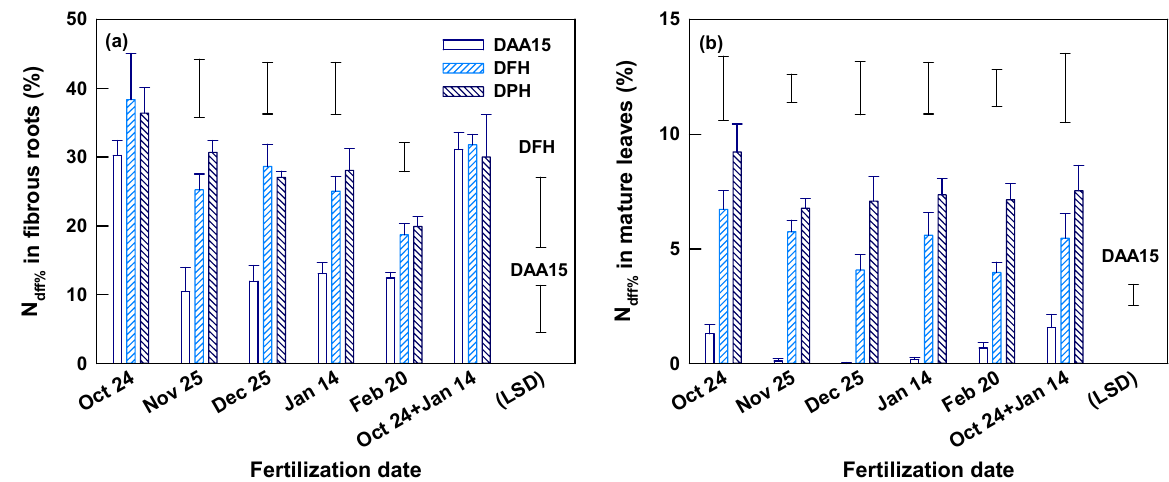
Figure 4. N dff% of fibrous root and mature leaves 15 days after 15 N fertilization (DAA15), on the days of first harvest (DFH) and post ‐ harvest (DPH) of spring shoots at Xingyang, Henan province. The data are means and SE ( n = 4). Single bars without symbols above columns represent LSD values indicating significant differences among DAA15, DFH, and DPH for each of the specified fertilization dates. A single bar without a symbol ticked with (LSD) represent LSD values indicating significant difference on DAA15, DFH ( a ), and DAA15 ( b ) among fertilization dates.